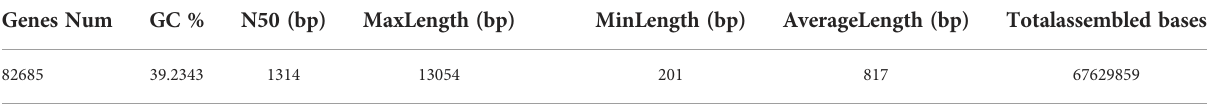
TABLE 2 De novo assembly